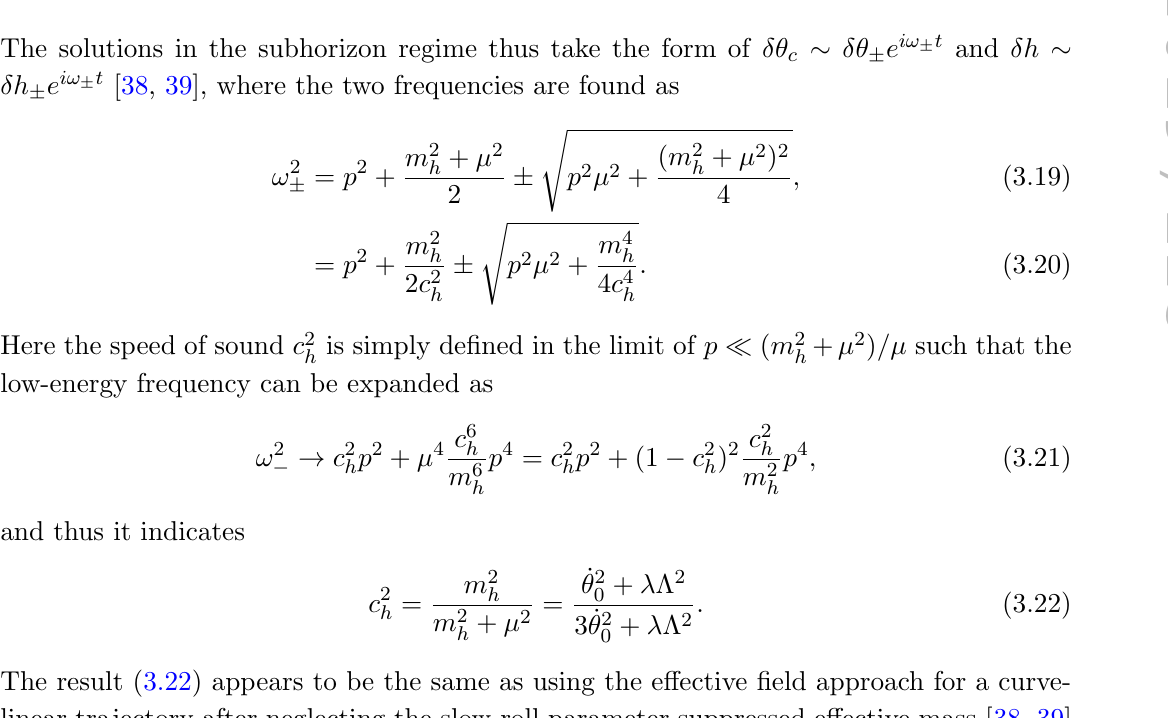
Figure 1 . The change of the dispersion relation with respect to the physical wavenumber p in the Hubble unit. For ! (1) the parameters (cid:3) = 2 H , (cid:21) = 0 : 01 and _ (cid:18) 0 = 0 : 1 H are used, which gives (cid:6) the parameters (cid:3) = 2 H , (cid:21) = 0 : 01 and _ (cid:18) 0 = 2 H are used, which gives (cid:22) (1) ’ 0 : 04 H . For ! (2) (cid:6) (cid:22) (2) ’ 4 H